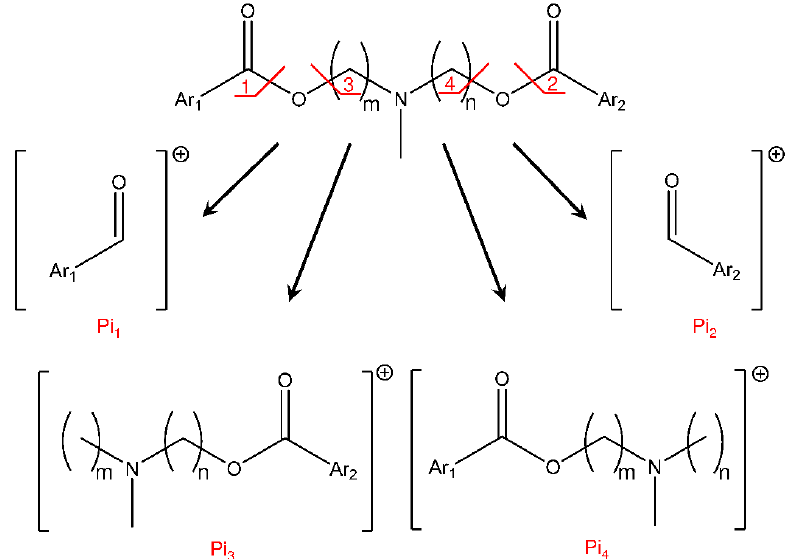
Figure 4. Common fragmentation pathways proposed for the studied P-gp inhibitors. Each bond cleavage site is marked by a red line and associated with a number, that is reported also to the related product ion (Pi).